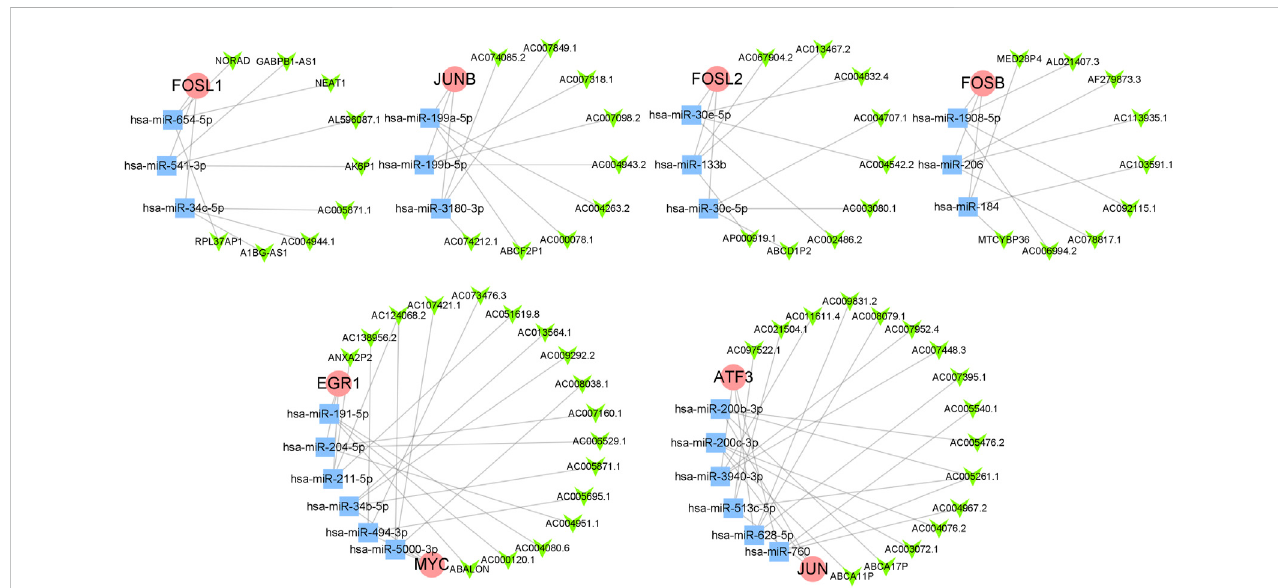
FIGURE 6 The ceRNA regulatory network of hub genes. The red circles represent hub genes, the blue squares represent miRNAs that targeted hub genes, and the green V-shapes represent lncRNAs that targeted miRNAs.